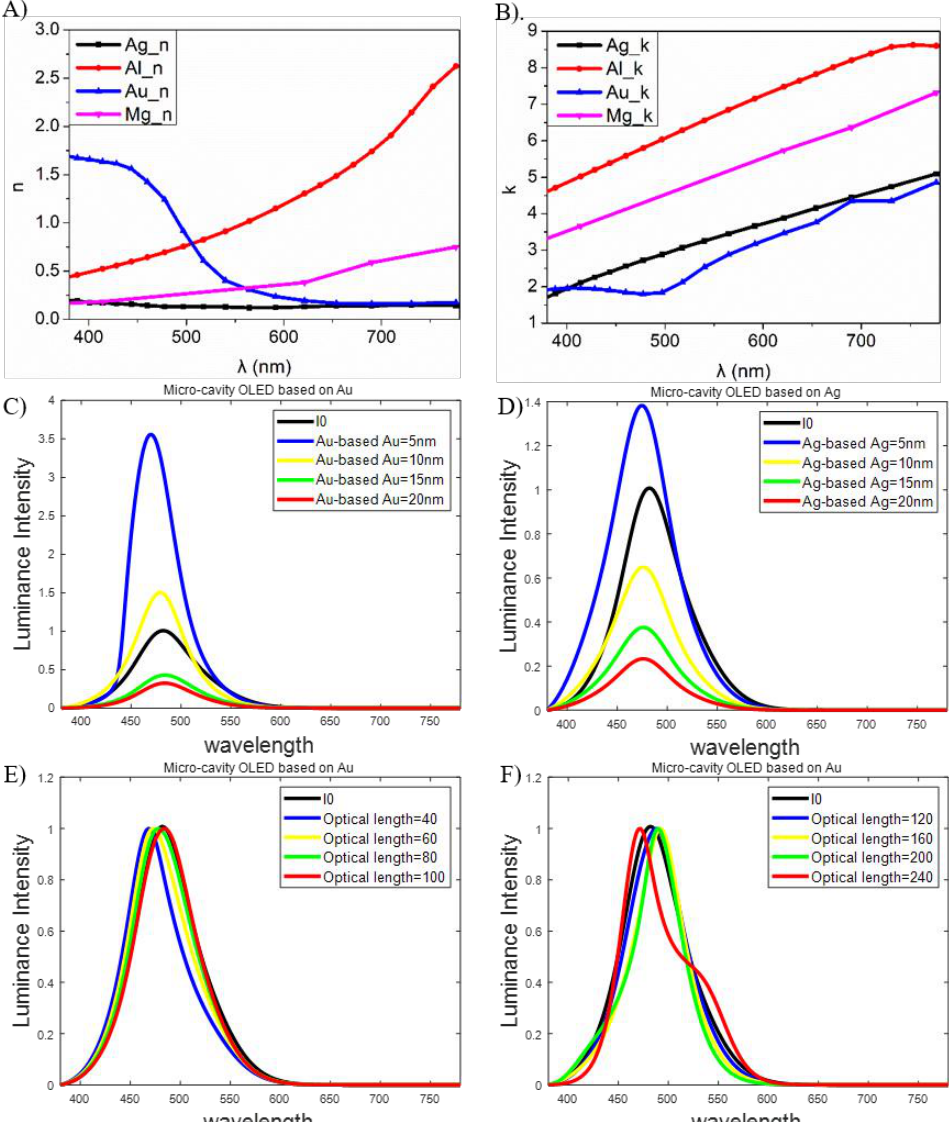
Figure 5. ( A ) Ordinary refractive indexes of different metals, ( B ) Extinction coefficients of different metals, ( C ) Simulated EL spectra of micro-cavity OLEDs based on Au with different thicknesses, ( D ) Simulated EL spectra of micro-cavity OLEDs based on Ag with different thicknesses, ( E , F ) Simulated EL spectra of micro-cavity OLEDs based on Au with different optical paths.